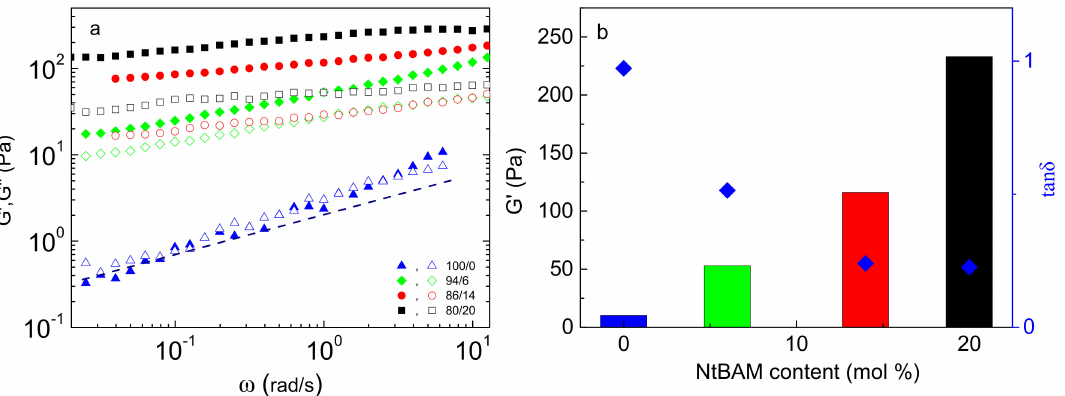
Figure 5. Frequency dependence of G’ (closed), G” (open) ( a ) for the NaALG- g -P(NIPAM x - co -NtBAM y )/water systems of different monomer compositions in the grafting chains, as indicated, at 37 ◦ C. The slope of the dashed line is 0.5. ( b ) Storage modulus, G’ (at 1 rad/s) (bars) and tan δ (diamonds, right axis) versus NtBAM content (mol %) of the grafting